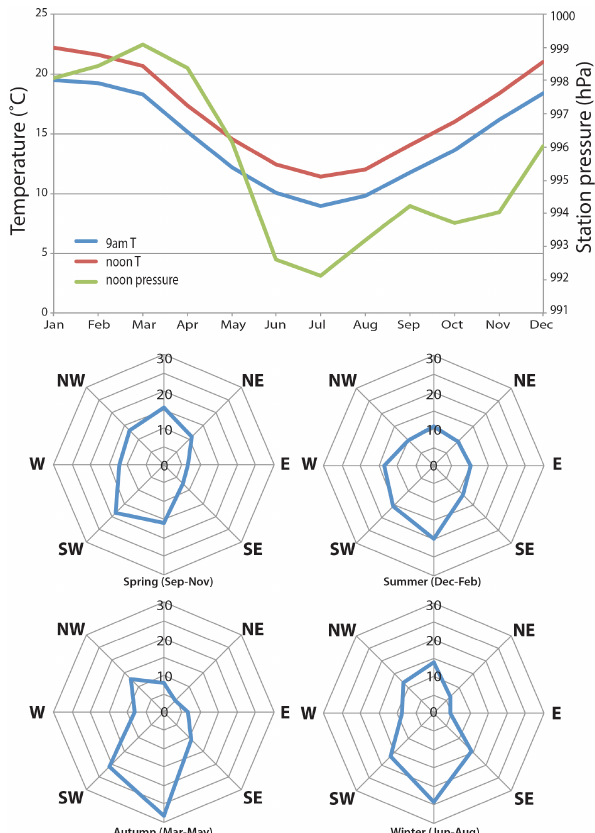
Figure 4. Top: climatology of 9a.m. temperature and noon tem- perature and pressure measured by Reverend Richard Davis at Wai- mate North and Kaikohe (means for 1839–1843 and 1848–1851 in- clusive). Bottom: seasonal wind climatology (% frequency observa- tion) for the same sites and